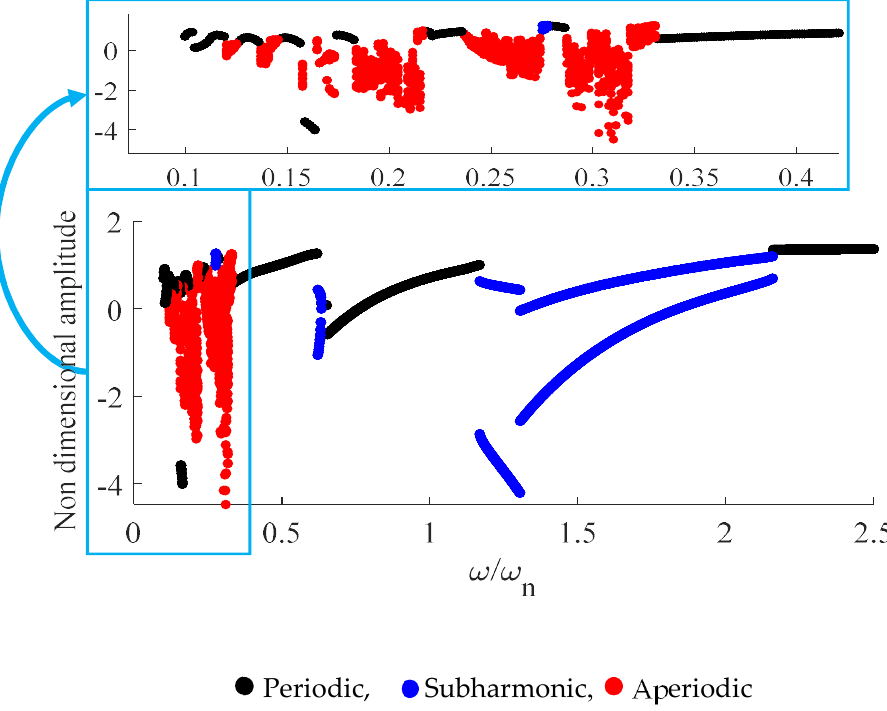
Periodic, Aperiodic Subharmonic , Figure 4. Bifurcation diagram based on backward simulation, case Figure 4. Bifurcation diagram based on backward simulation, case 1.